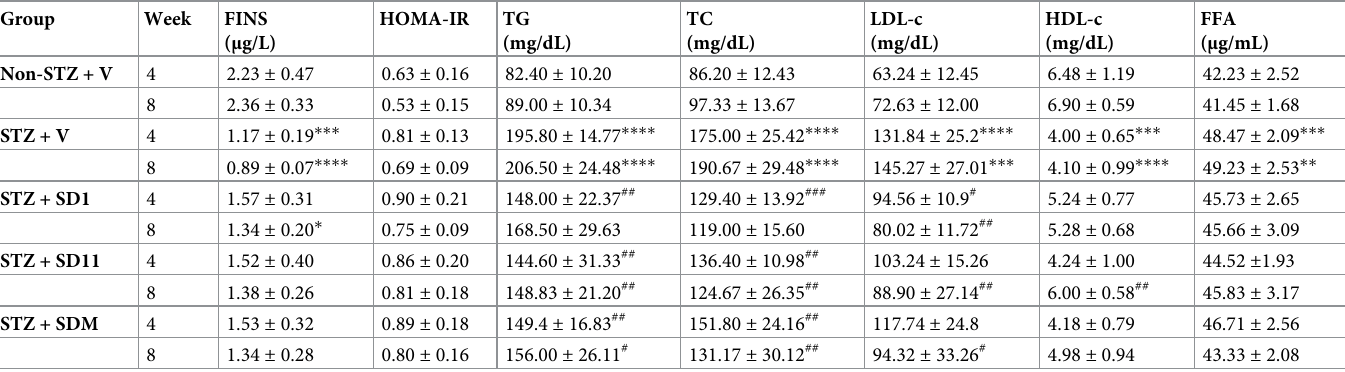
Table 1. Assessment of serum biochemistry among experimental